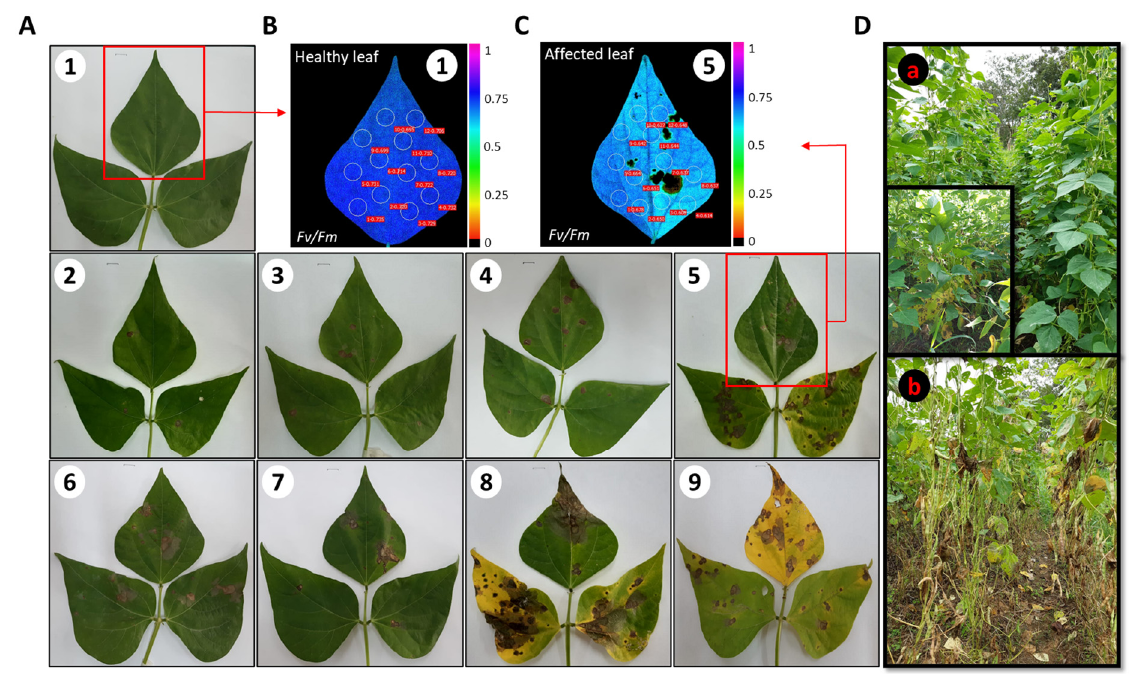
Figure 9. Selection of leaves, leaflets, and locations of areas of interest (AOI) for physiological evaluation in beans: ( A ) different WB severity scale scores (from 1 to 9 according to their degree of visual effect, from 1, no visible symptoms, to 9, as maximum WB severity level; ( B , C ) areas of interest (AOI) selected in each leaflet of healthy and infected leaves of Phaseolus vulgaris , respectively; figures showing the maximum quantum efficiency of PSII (F v /F m ) in healthy and infected leaves, respectively; the variations in the color gradient from violet to red (from 1 to 0) indicate the decrease in value of the F v /F m ratio as a response to disease stress; ( D ) ( a ): State of disease development for the leaf samples taken following the BBCH scale for beans, which corresponds to the BBCH 79 crop growth stage [84] with a close-up view of disease development; and ( b ): advanced stage of disease stress, with severe disease symptoms (scale 9).